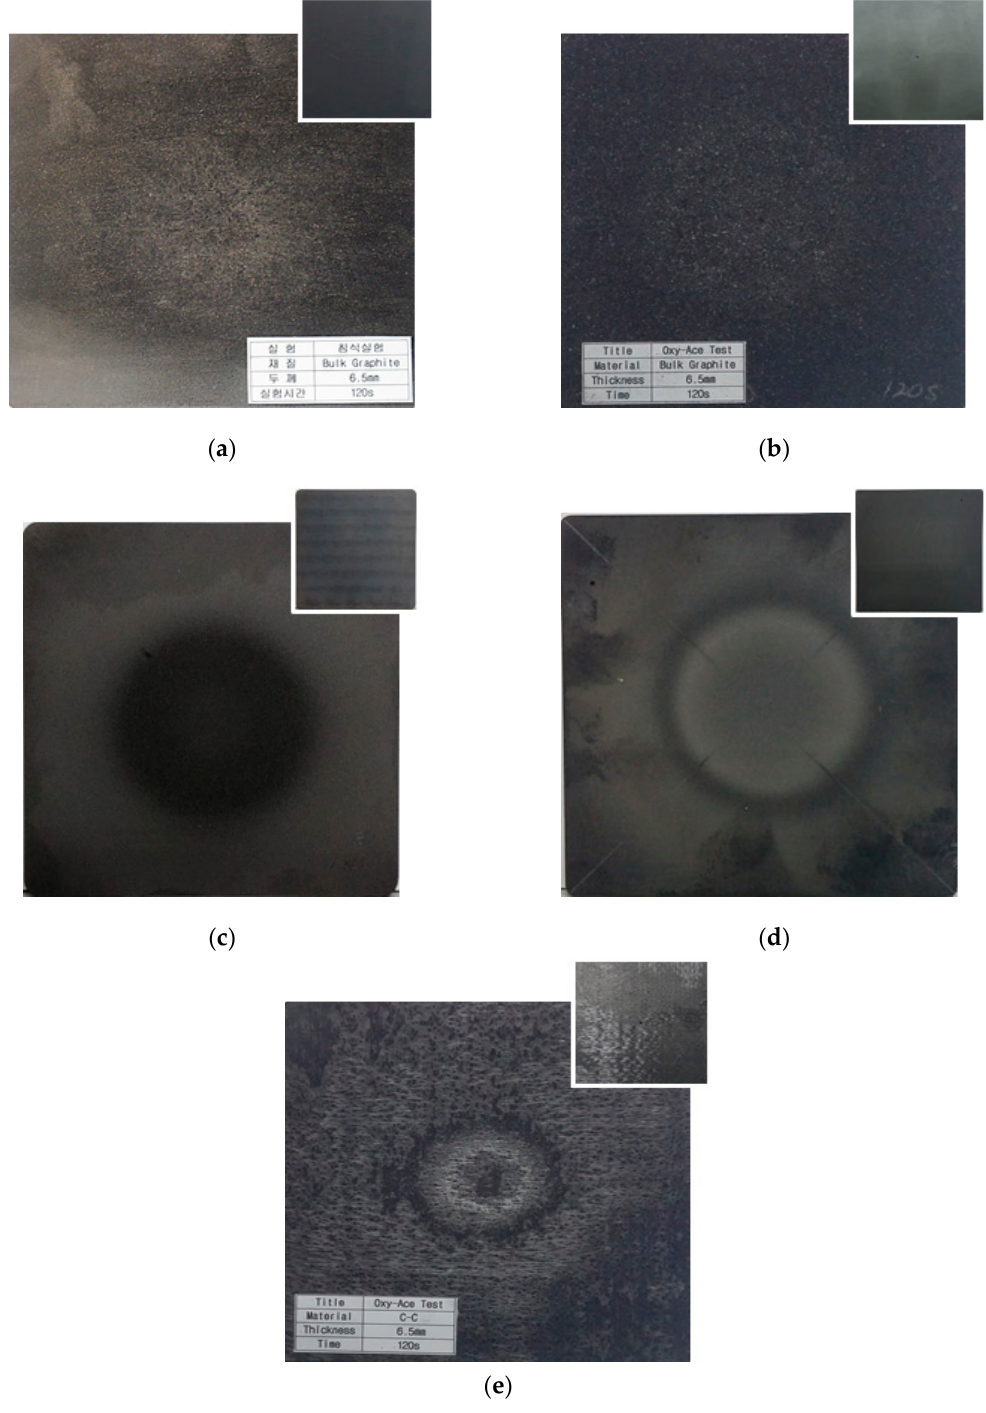
Figure 6. The eroded surface of ( a ) Graphite R4340, ( b ) Graphite G6520, ( c ) Graphite EX60, ( d ) Graphite EX70, ( e ) 3D C–C